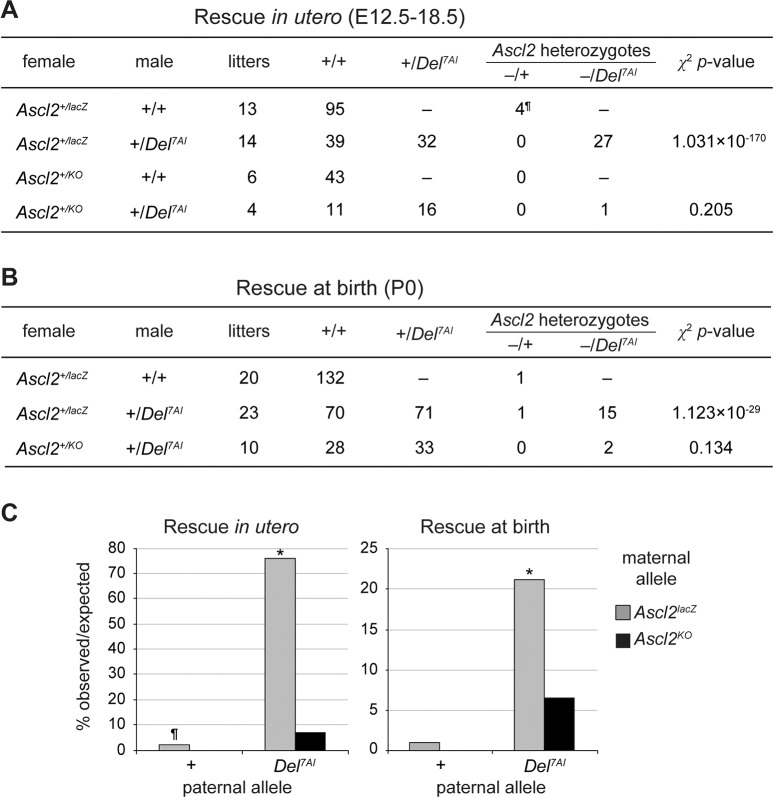
Phenotypic rescue of the mid-gestational lethality of Ascl2 mutants by paternal inheritance of Del7AI.(A) Number of rescued embryos at E12.5 to E18.5 from crosses between Ascl2+/lacZ or Ascl2+/KO females and +/+ or +/Del7AI males. ¶: includes 3 small and necrotic embryos. The data for individual litters are presented in S1 Table. (B) Number of live Ascl2 mutant pups at birth obtained from similar crosses. (C) Bar charts showing the percentage observed over expected values from crosses analyzed in utero (left) and at birth (right). X-axis: male genotypes. Values from crosses involving Ascl2+/lacZ and Ascl2+/KO females are shown in grey and black, respectively. The probability values were obtained by the chi-square test of the null hypothesis of Del7AI
= WT, where the rescue frequency of the wild-type allele, 0.901%, is based on all crosses involving the Ascl2lacZ allele (3/333 Ascl2lacZ/+ progeny). * p<1×10−10.